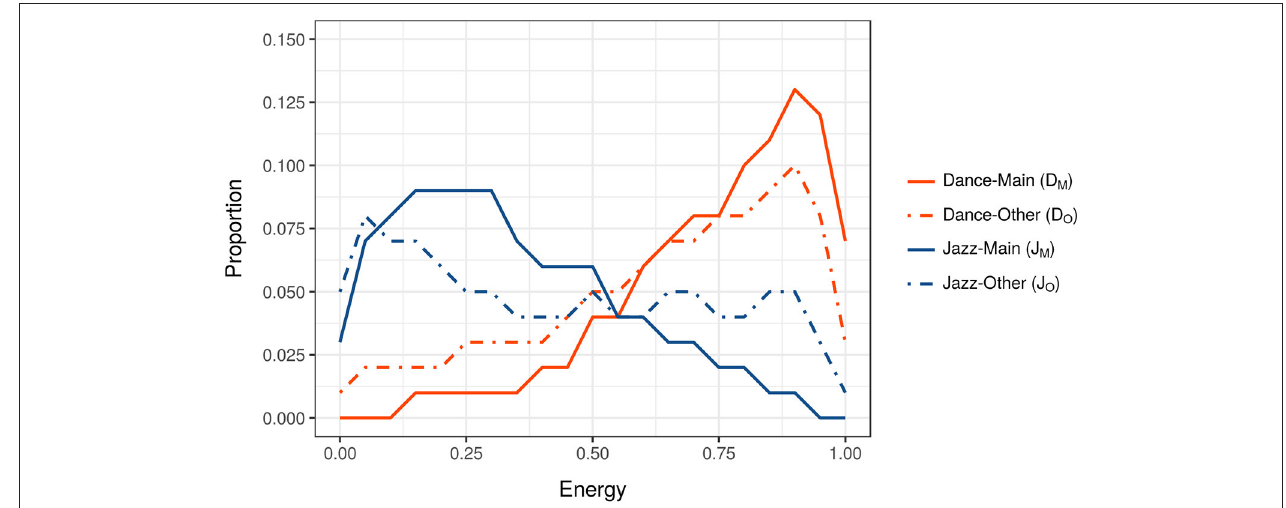
FIGURE 1 | Energy distributions of tracks belonging to Dance-head and Jazz-head subgroups. The orange lines, D M and D O , show the distributions of tracks downloaded by Dance-heads; the blue lines, J M and J O , show the distributions of tracks downloaded by Jazz-heads.